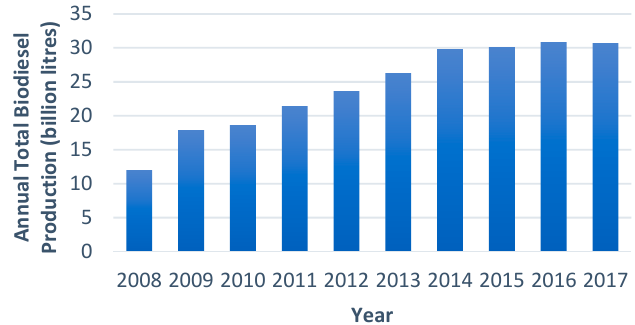
Figure 2. Annual total biodiesel production for the last ten (10) years. Data obtained from REN21 [21]. Table 1. Common feedstocks of biodiesel production by di ff erent countries [23–26]. Feedstocks